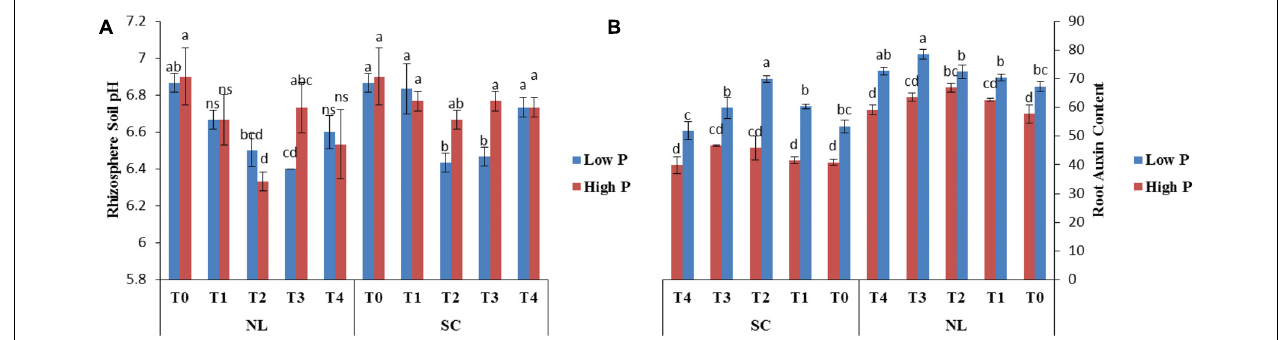
FIGURE 12 | Effect of Ti application on (A) rhizosphere soil pH and (B) root Auxin content of soybean under NL and SC combined with LP and HP conditions. The bar plots with different lettering show the significant difference among cultivars at probability < 0.05. The error bars are the ± SD values with n = 3.